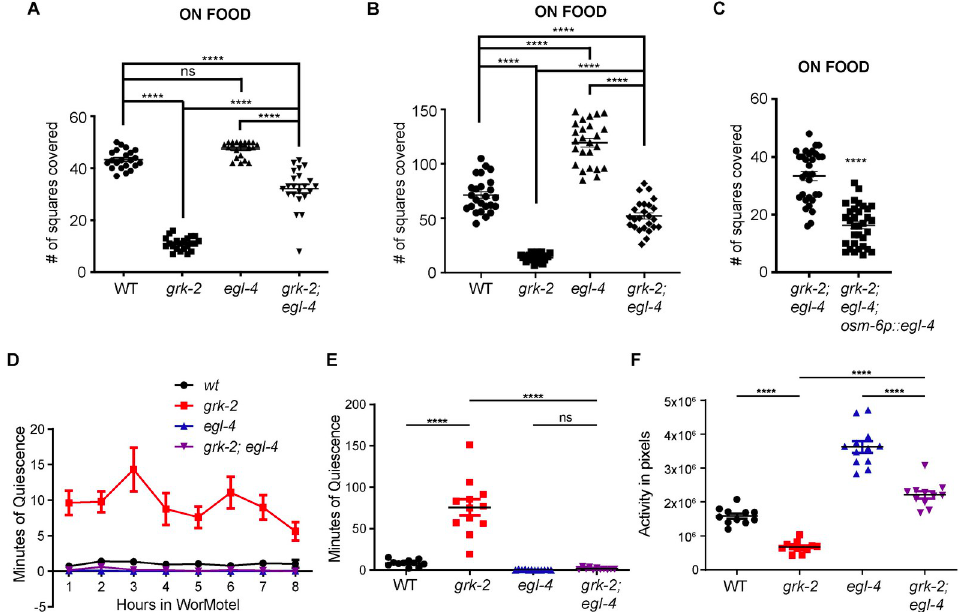
Fig 4. egl-4 suppresses the exploration defect, movement quiescence, and reduced activity of grk-2 mutant animals. (A), (B) The egl-4(n479) mutation partially suppresses the exploration defect of grk-2(gk268) mutant as assayed on 6 cm (A) and 10 cm (B) plates. Shown is the number of squares (out of 50, (A) or 150, (B)) single animals covered in ~20 h. Please note that egl-4 mutant animals explore more than wild type animals as assayed on 10 cm plates. ( ���� , P < 0.0001. ns, P > 0.05. One way ANOVA followed by a Bonferroni test. Error bars = SEM; n = 22–26). (C) Expression of egl-4 cDNA in ciliated sensory neurons under the osm-6 promoter reverses the egl-4 suppression of the exploration defect of grk-2 mutant ( osm-6p :: egl-4 , transgene yakEx221 ). Shown is the number of squares single animals covered in ~20 h ( ���� , P < 0.0001. ns, P > 0.05. Student’s t-test. Error bars = SEM; n = 31–33). (D) grk-2(gk268) mutant animals show enhanced movement quiescence, and the egl-4(n479) mutation suppresses this phenotype. The graph shows the average minutes animals spent in quiescence per hour in the WorMotel. Quiescence is the time when zero worm pixels moved between two frames separated by 10 sec (See Methods). One WT animal was considered an outlier and was not included in the graph since its values were more than 3 standard deviations from the mean. (E) The graph shows the total minutes individual animals spent in quiescence in 8 h in the WorMotel. ( ���� , P < 0.0001. ns, P > 0.05. One way ANOVA. Error bars = SEM; n = 11–12). (F) grk-2(gk268) mutant animals show reduced activity, and the egl-4(n479) mutation partially suppresses this phenotype. The graph shows the activity in pixels of individual animals in 8 h in the WorMotel. Activity is the number of pixels moved between frames separated by 10 sec. ( ���� , P < 0.0001. One way ANOVA. Error bars = SEM; n =